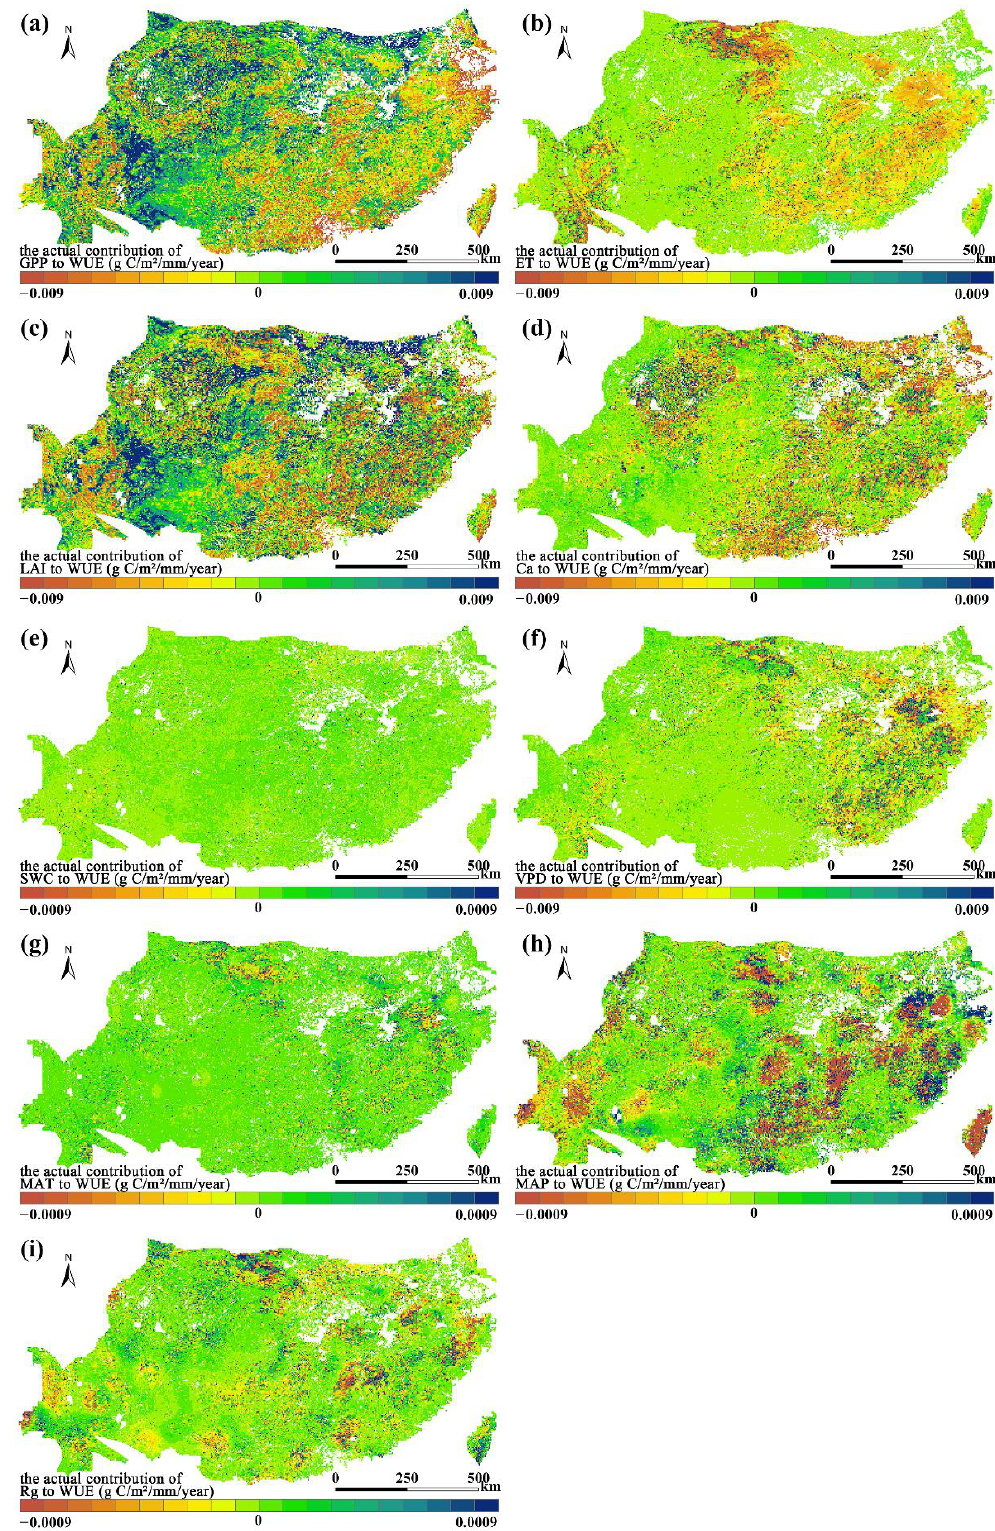
Figure 4. Spatial variations in the actual contribution of ( a ) GPP, ( b ) ET ( c ) LAI, ( d ) Ca, ( e ) SWC, ( f ) VPD, ( g ) MAT, ( h ) MAP, and ( i ) Rg to WUE in the subtropical region of China (STC).